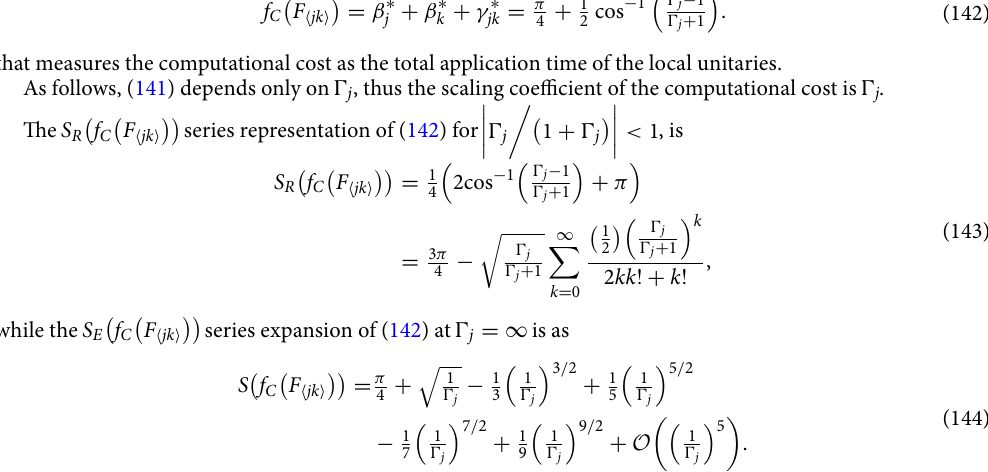
[0, 1000] ∈ ϕ ∗ ( t ) N , jk (cid:31) (cid:31) (cid:31)